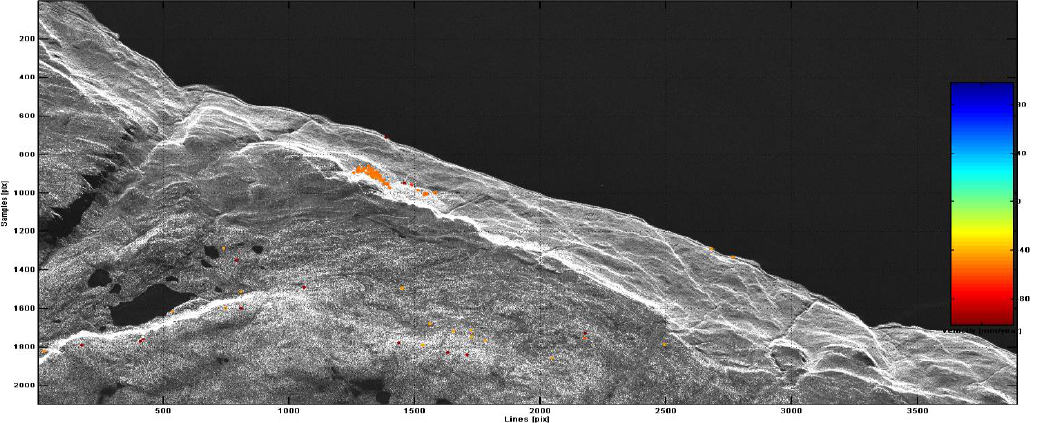
Figure. 8 Subsidence map obtained through the PSInSAR Processing of study